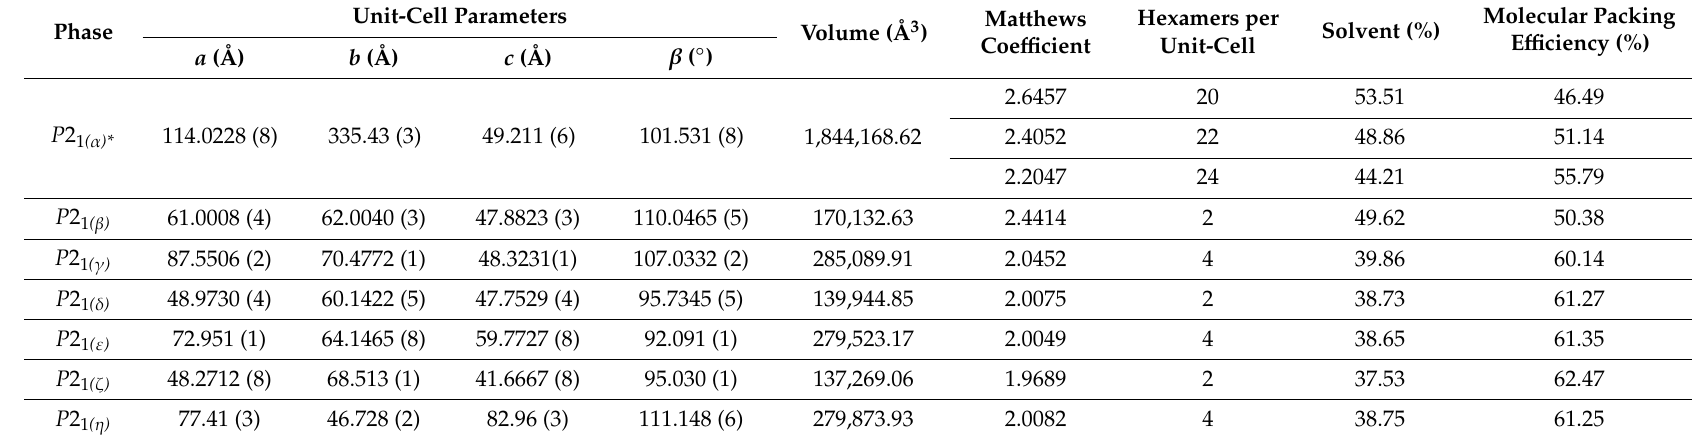
Table 3. Unit-cell parameters and molecular packing e ffi ciency for the seven P 2 1 HI polymorphs reported in literature. * Due to the large unit-cell volume, there are multiple valid Matthews coe ffi cient values with high probability of occurrence